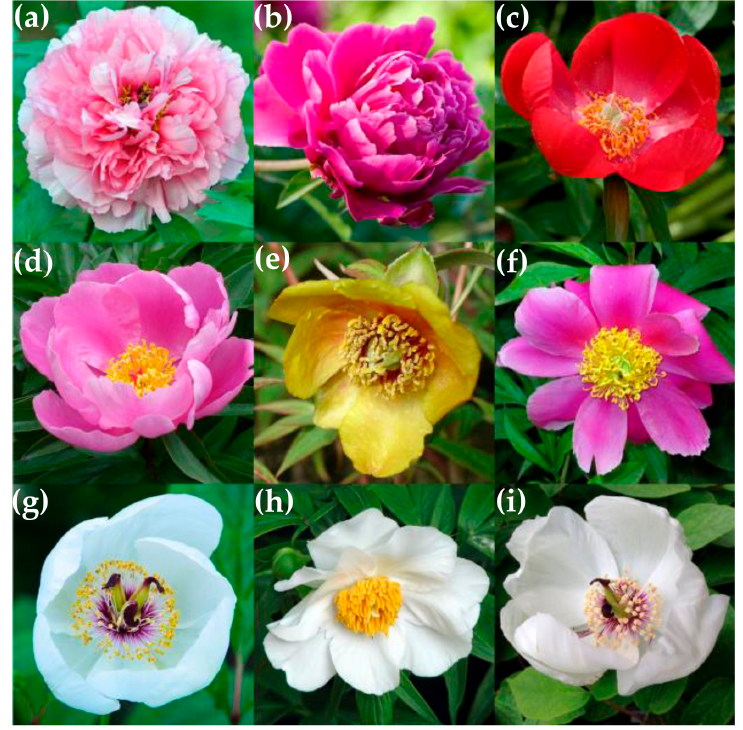
Figure 1. The flowers of the chemically investigated nine species of the genus Paeonia . ( a ) P. albiflora ; ( b ) P. delavayi ; ( c ) P. emodi ; ( d ) P. japonica ; ( e ) P. lactiflora ; ( f ) P. obovata ; ( g ) P. peregrina ; ( h ) P. suffruticosa ; ( i ) P. veitchii . (https://it.wikipedia.org/wiki/Paeonia).